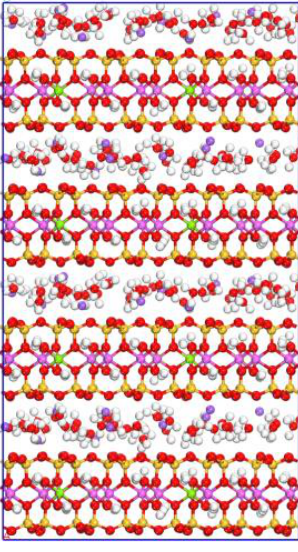
Figure 10. Equilibrium snapshot from an MD simulation of a montmorillonite supercell containing 50 structural water molecules in two neighboring layers at 298 K, 1 bar.